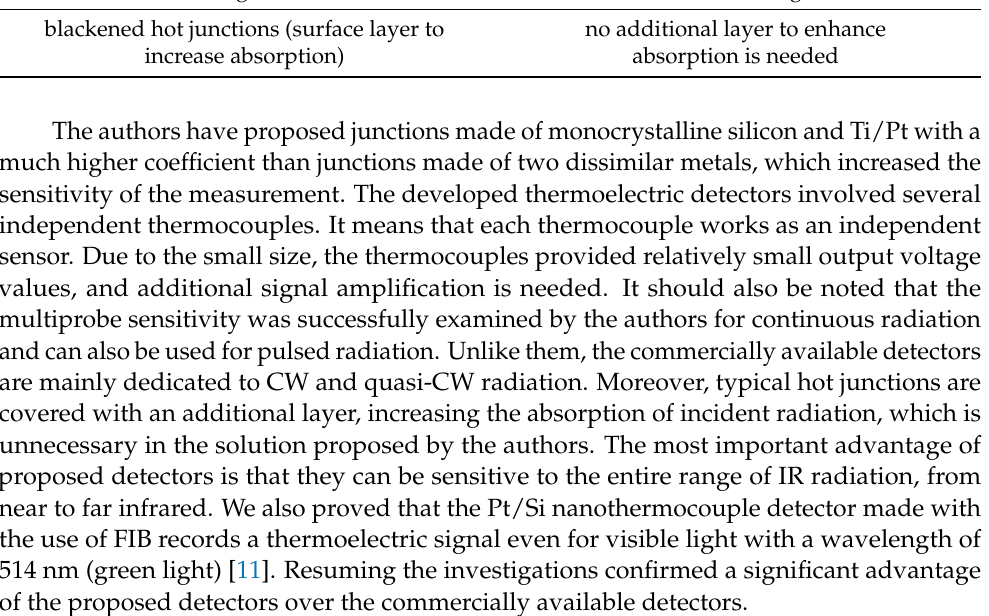
Table 1. The comparison of market-available sensors and tested thermocouples. Commercially Available Sensors [6,7] The Developed Thermocouples a junction of two dissimilar metals (usually bismuth and antimony) the output voltage is provided by a series of thermocouples (20–120 thermocouples) in a radial, tight arrangement usually dedicated to detecting CW and quasi-CW radiation additional cooling elements needed no additional cooling needed blackened hot junctions (surface layer to increase absorption)